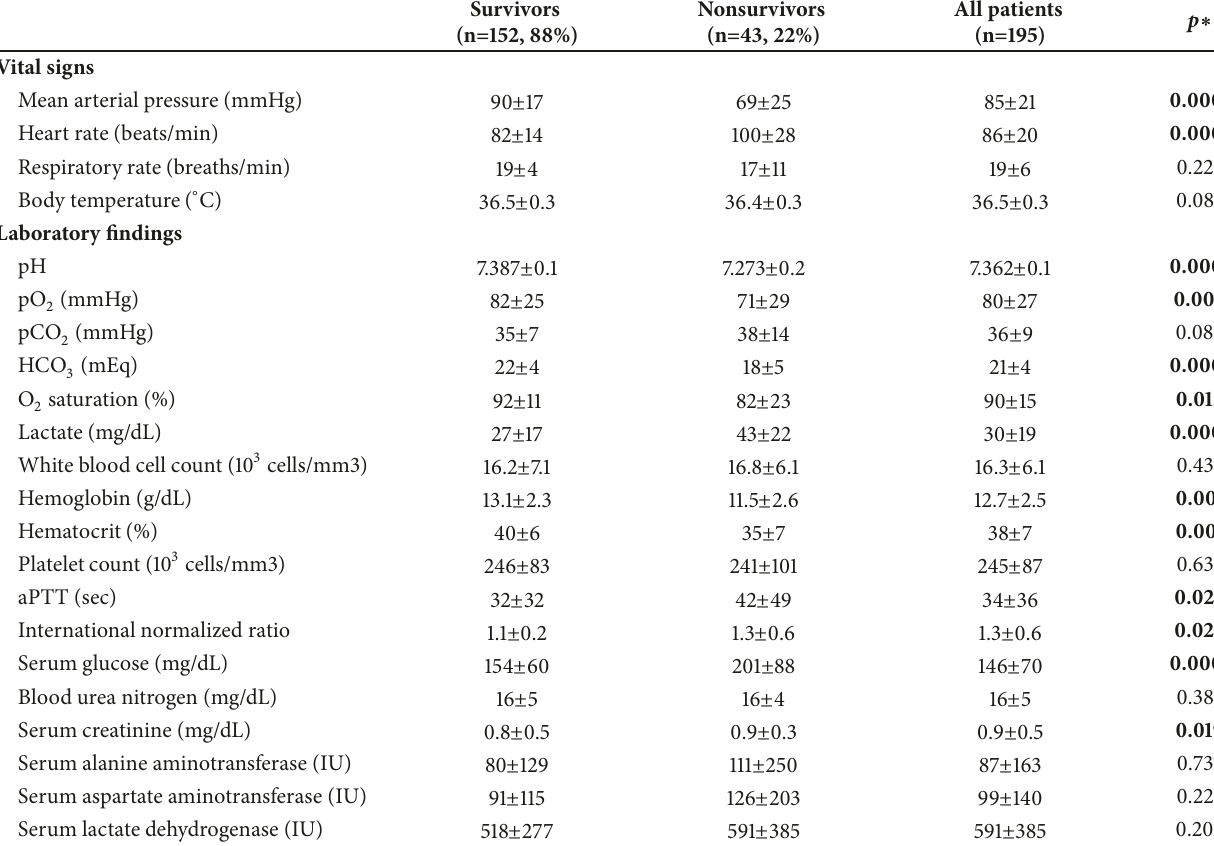
Table 3: Patients’ vital signs and laboratory findings during emergency